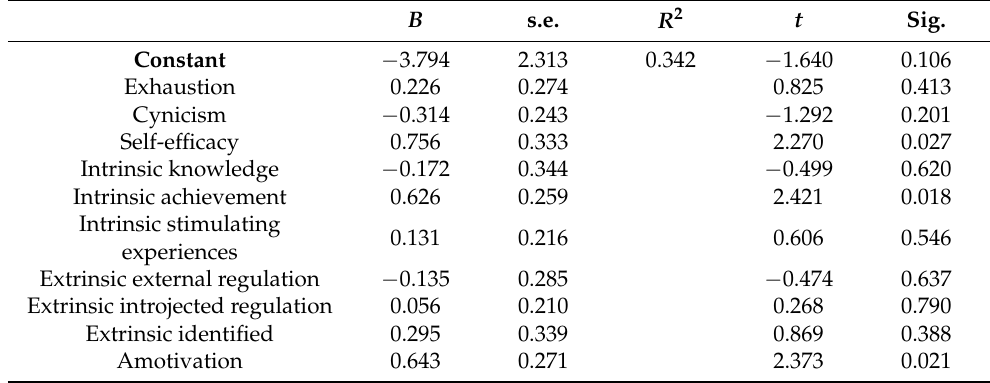
Table 5. Regression